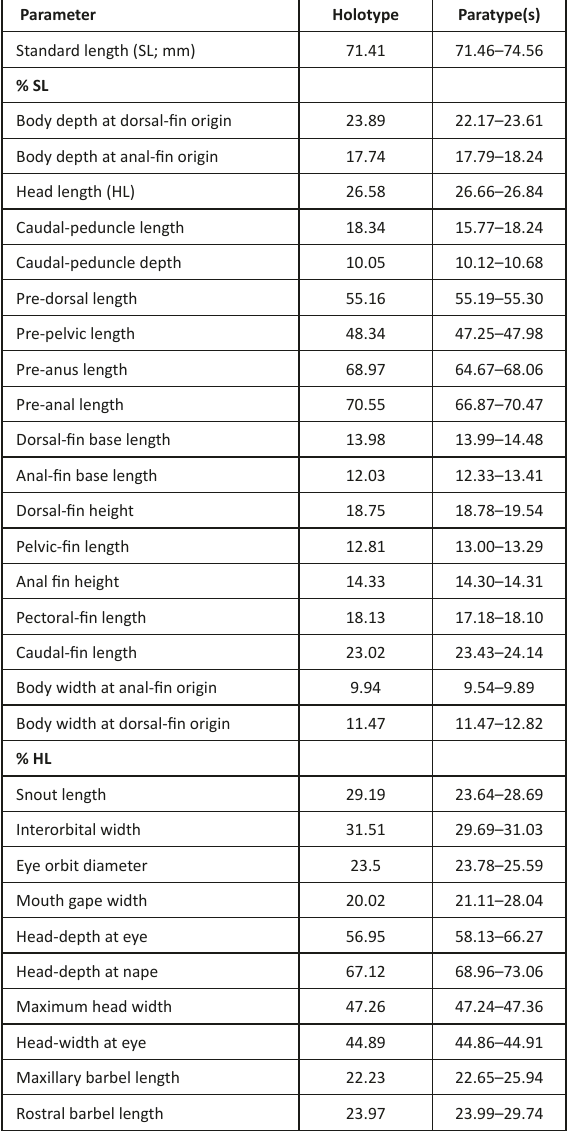
Table 1. Morphometric data of Barilius torsai sp.